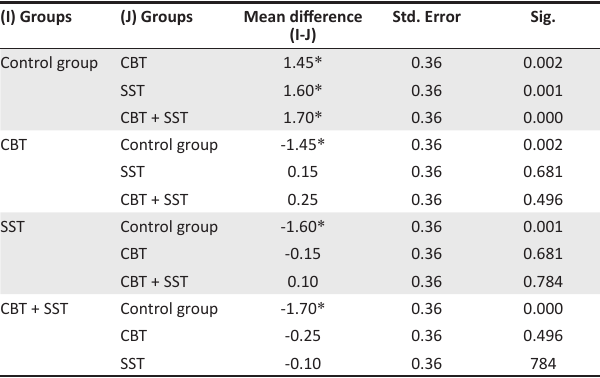
TABLE 5: Showing the post hoc analysis on the efficacy of cognitive-behavioural therapy, social skills training and combined cognitive-behavioural therapy and social skills training in the treatment of conduct disorder amongst in-school adolescents.